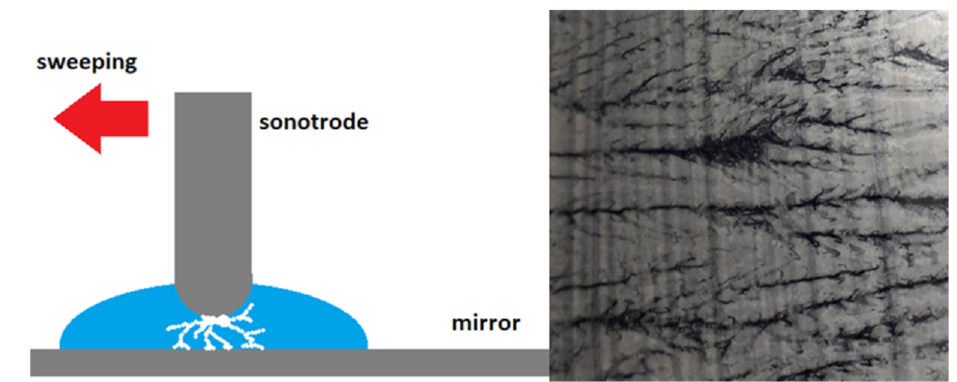
Figure 9. Inhomogeneous cleaning under low cleaning conditions for an intensively soiled mirror.